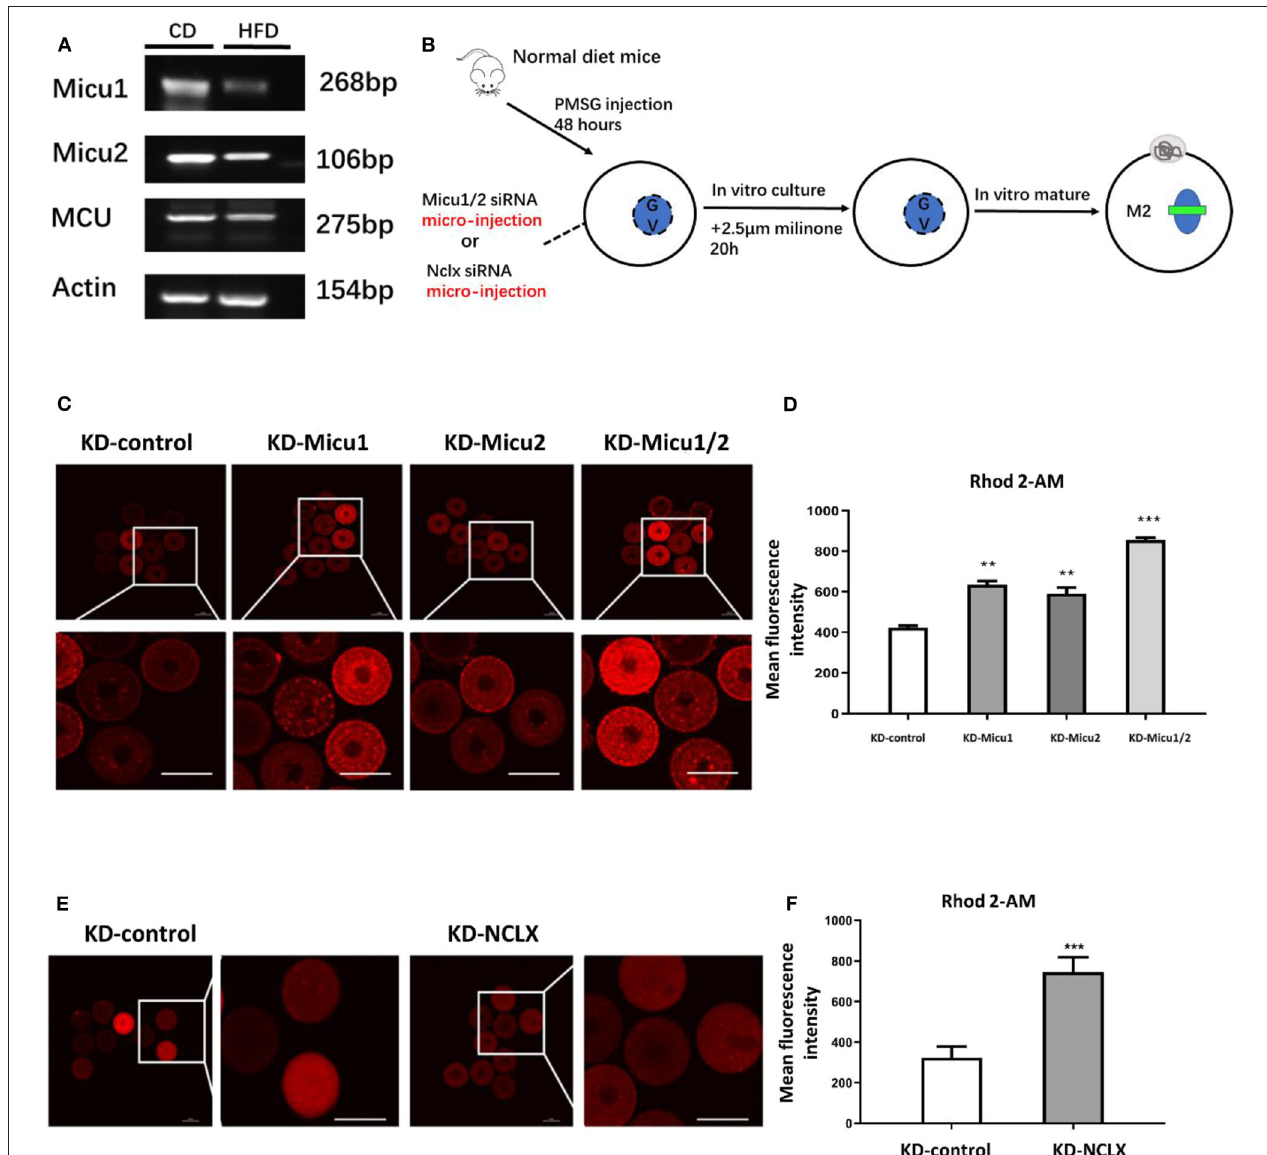
FIGURE 1 | Micu1/Micu2 or NCLX knockdown induces mitochondrial Ca 2 + overload in mouse oocytes. (A) The mRNA levels of Micu1 and Micu2 in obese mouse oocytes. (B) The process about establishment of the mouse oocyte calcium overload model by microinjection special siRNA sequence to knockdown expression about Micu1 and Micu2 as well as NCLX in mouse oocytes. (C) Representative images of Rhod-2 AM fluorescence (red) in germinal vesicle (GV) stage oocytes treated with KD-control, KD-Micu1, KD-Micu2, and KD-Micu1/2. Scale bar: 50 µ m. (D) Quantification of the relative levels of mitochondrial Ca 2 + in KD-control, KD-Micu1, KD-Micu2, and KD-Micu1/2 injected GV-stage oocytes. ( n = 50 for each group). (E) Representative images of Rhod-2 AM fluorescence (red) in GV-stage oocytes from KD-control and KD-NCLX. Scale bar: 50 µ m. (F) Quantification of the relative levels of mitochondrial Ca 2 + in GV-stage oocytes from KD-control and KD-NCLX. ( n = 50 for each group). Student’s t- test and one-way ANOVA were utilized for statistical analyses. ** P < 0.01; *** P < 0.001 vs. control group. Error bars indicate